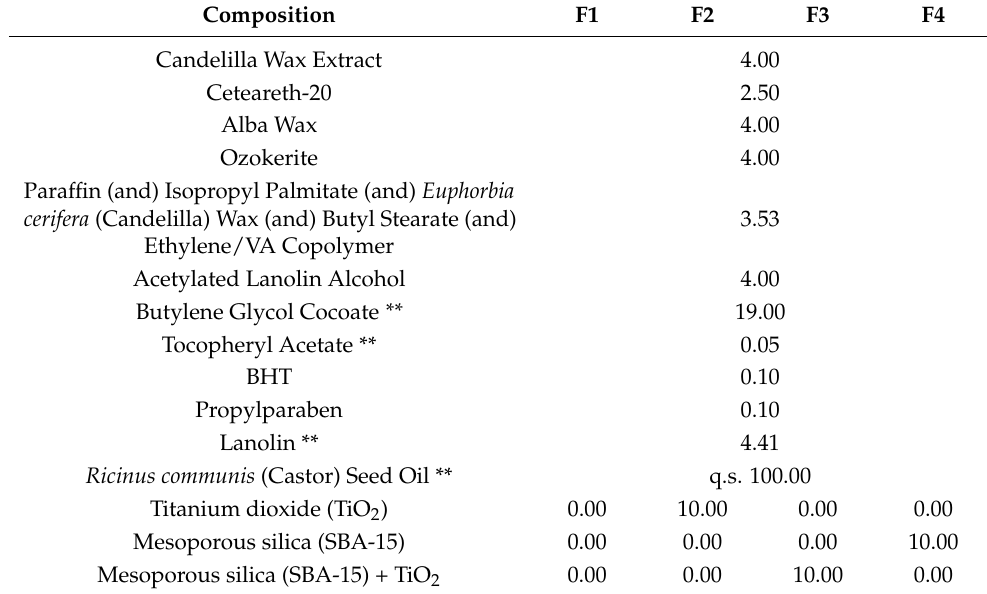
Table 1. Quantitative and qualitative composition (% w / w ) of the photoprotective formulations prepared as